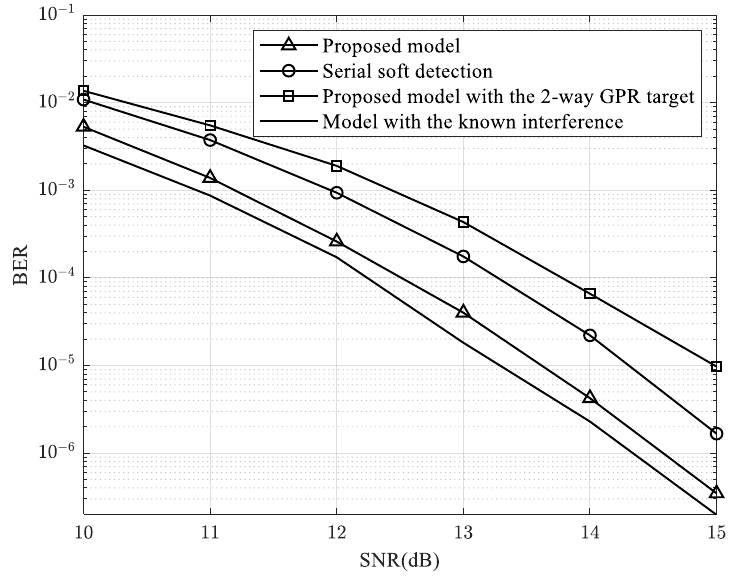
Figure 9. BER performance of the proposed model and models from previous works.